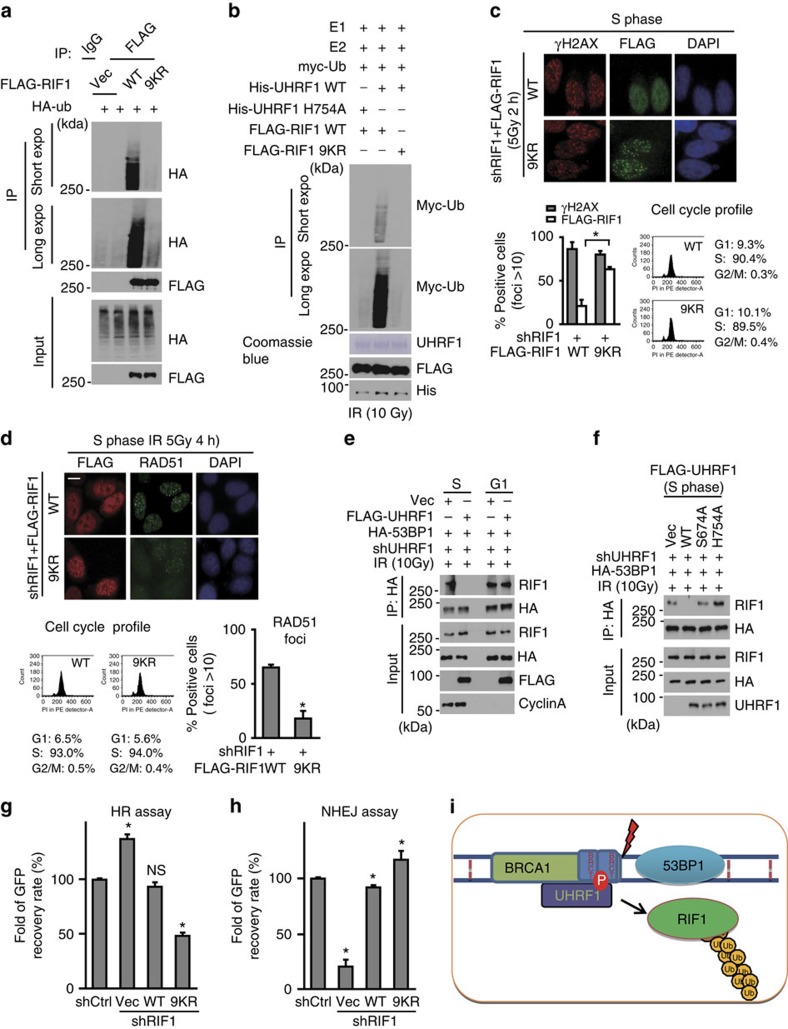
RIF1 ubiquitination by UHRF1 is important for its accumulation at DSB sites.(a). Abrogation of RIF1 ubiquitination. HEK 293T cells stably expressing RIF1 shRNA were reconstituted with the indicated constructs. In vivo ubiquitination assay was performed as described in Methods. (b) UHRF1 ubiquitinates RIF1 in vitro. An in vitro ubiquitination assay was performed using recombinant UHRF1, ubiquitin, UBC13/Mms2 and UBE1 (See Methods). (c) Ubiquitination of RIF1 is required for its recruitment to the DSB sites. HeLa cells stably expressing RIF1 shRNA were reconstituted with the indicated constructs and synchronized. Flag-RIF1 focus formation was then examined following irradiation (5 Gy) as indicated. Upper: Representative micrographs. Lower: quantification of the positive cells (foci>10 per cell) and cell cycle profile. For each sample, 600 randomly selected cells were counted. Data presented as mean±s.d. of three biological triplicates. RIF1 foci Positive cell percentage compared between WT and 9KR group. *P<0.05. (d) Ubiquitination of RIF1 is required for RAD51 accumulation at DSBs. HeLa cells stably expressing RIF1 shRNA were reconstituted with the indicated constructs. Rad51 foci formation was examined 4 h following irradiation (5 Gy). Upper: Representative micrographs; Lower: Quantification of the positive cells (foci>10 per cell). For each sample, 600 randomly selected cells were counted. Data presented as mean±s.d. of three biological triplicates. *P<0.05. (e) HEK 293T cells stably expressing UHRF1 shRNA were transfected with the indicated constructs and synchronized at G1 or S phase, and 53BP1 and RIF1 interaction was examined. (f) HEK 293T cells stably expressing UHRF1 shRNA were reconstituted with the indicated constructs. 53BP1 and RIF1 interaction was examined following synchronization at S phase. (g,h) Ubiquitination of RIF1 is required for its function in DSB repair. RIF1 was depleted in HEK 293 cells integrated with HR or NHEJ reporter. Cells were reconstituted with the indicated constructs and subjected to HR assay (g) and NHEJ assay (h) as described in the Methods. Data presented as mean±s.d. of three biological triplicates. Positive cell percentage compared with control group. *P<0.05. NS: no siginficant difference. (i) Schematic model illustrating Figs 4.